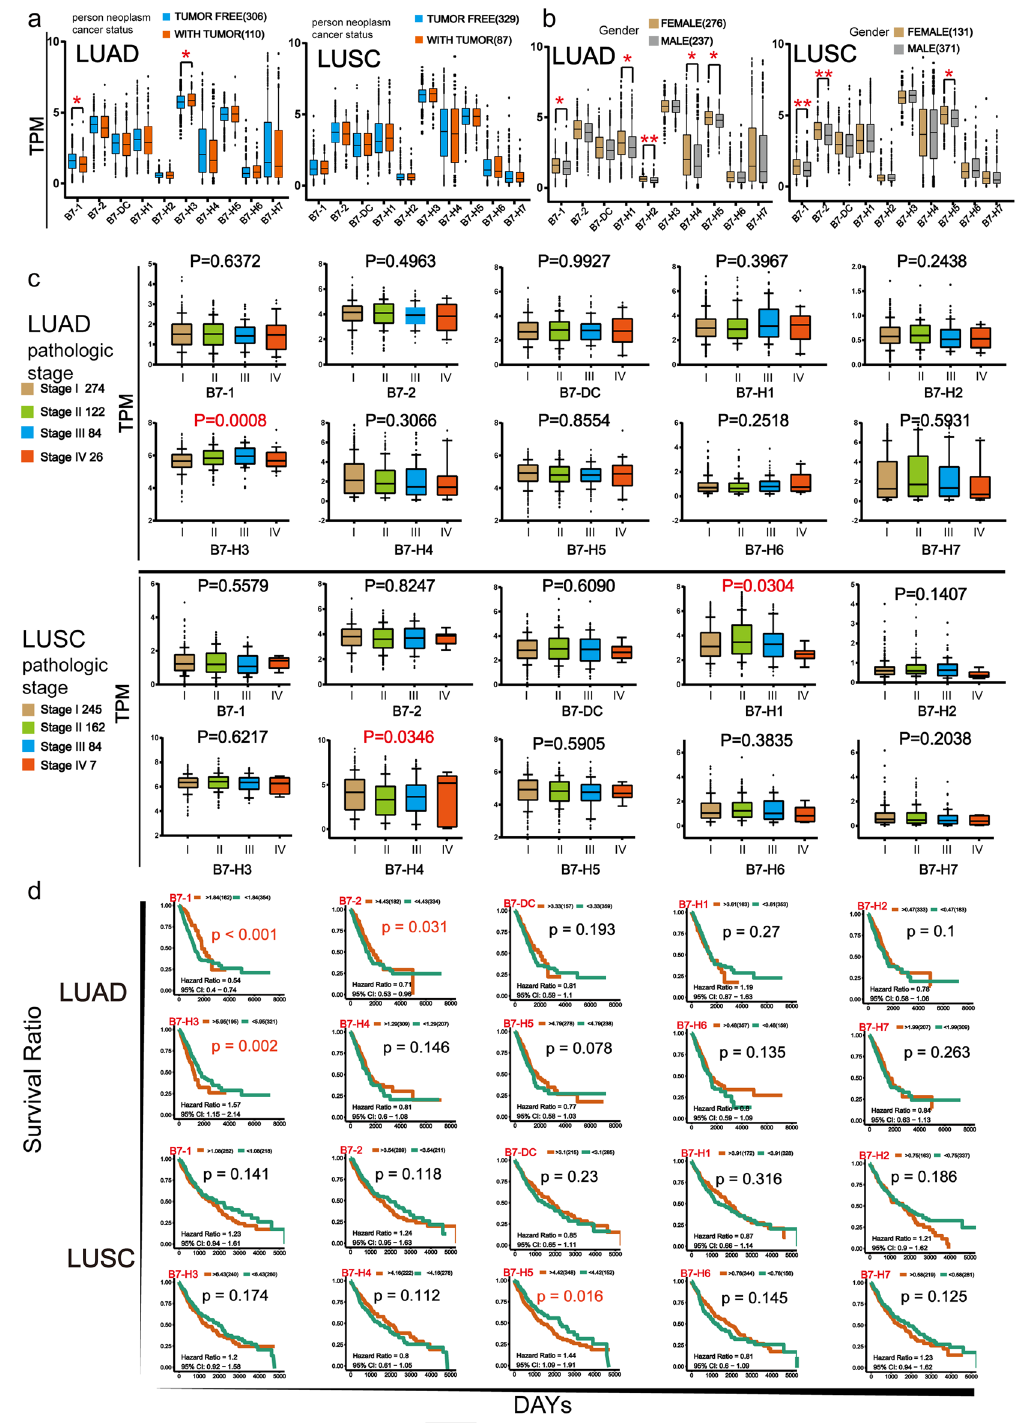
Figure 3. The association ofB7 family expression with clinicopathological parametersand patient survival. The relationship between the expression of B7 family members and ( a ) cancer status (* P < 0.05; ** P < 0.01 and *** P < 0.001), ( b ) gender and ( c ) pathologic stages (Stage I, Stage II, Stage III, Stage IV). ( d ) Kaplan–Meier survival curves for different subtypes of NSCLC patients stratified according to high vs low expression of B7